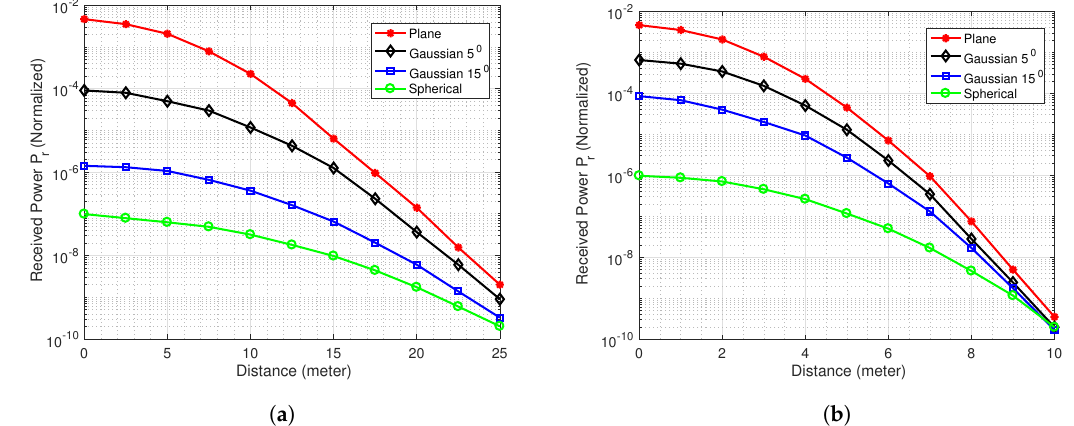
Figure 4. ( a ) Normalized received power ( P r ) for plane, Gaussian, and spherical beams in clean water; ( b ) Normalized received power ( P r ) for plane, Gaussian, and spherical beams in turbid water.